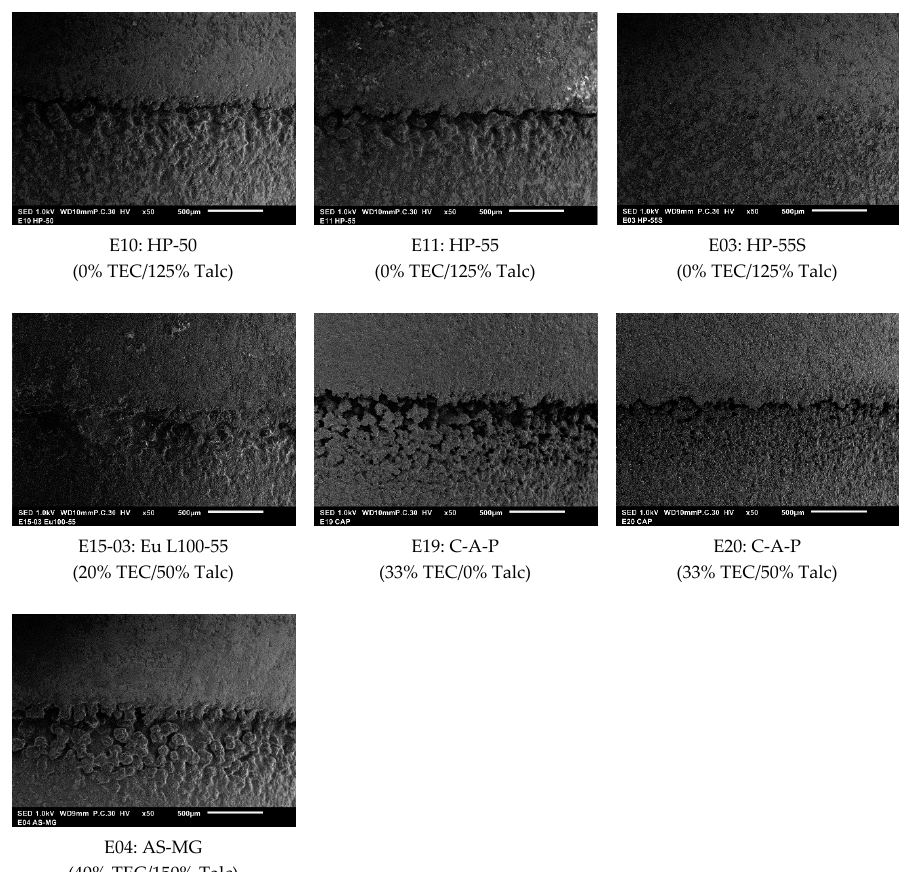
Figure 2. Scanning electron microscopy (SEM) images displaying the gap junction between capsule top and bottom after coating. % TEC and talc are based on dry polymer weight.